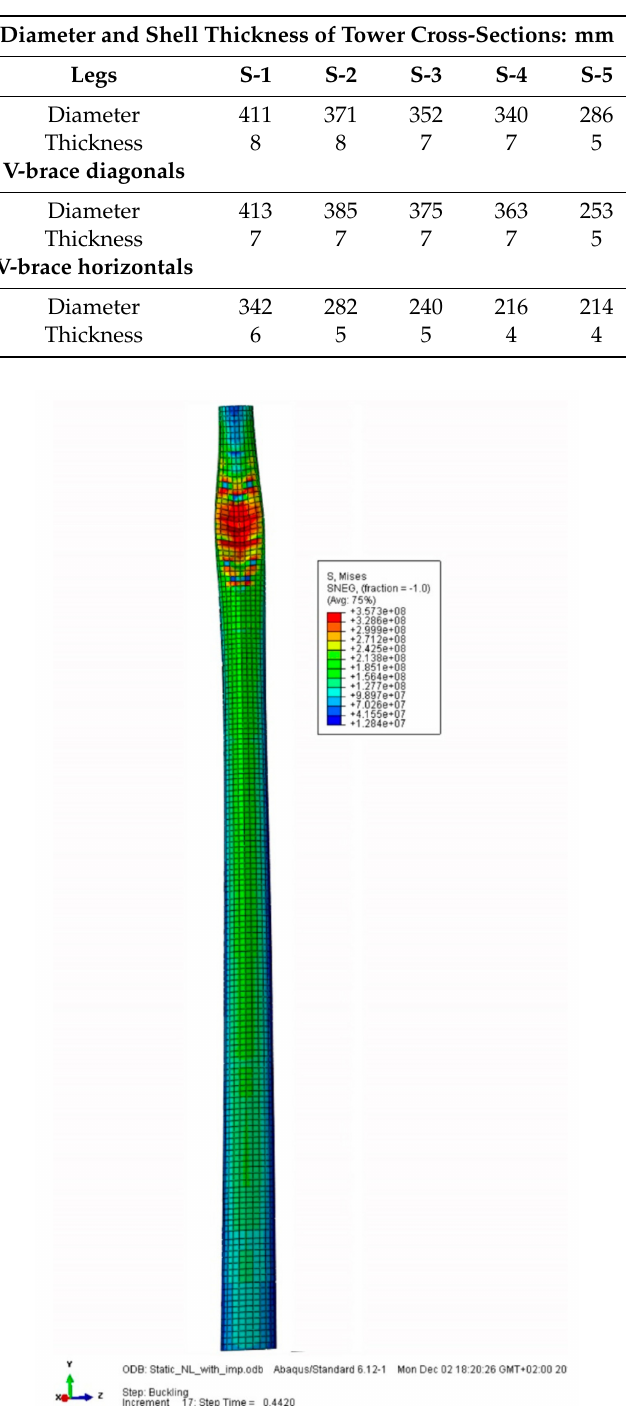
Figure 8. Material non-linear imperfection analysis results for